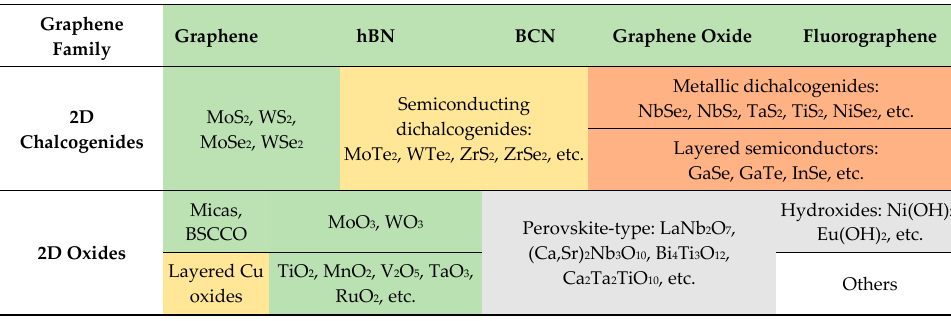
Table 1. Overview of the different groups of atomically thin 2D materials. Adapted from Ref. [41] with updated information from Ref. [42] for 2D oxides. The graphene family includes carbon-based 2D materials, such as graphene and its derivatives, and hBN (known as “white graphene”) and BCN. The 2D chalcogenides consist of all 2D compounds based on S, Se, and Te. The 2D Oxides gather those containing oxygen, excluding graphene oxide. The materials that have been proven to be stable in air and at room temperature are shaded in green. Those that could probably be stable under certain conditions given their similarities with the first group are shaded in yellow. Those that are known to be unstable in air but could be stable in certain inert atmospheres are shaded in orange/red. Finally, the grey-shaded compounds have been successfully obtained in the form of monolayers, which does not currently have much available information. “Others” indicates every other atomically thin crystal that could have been isolated or could be in the future.